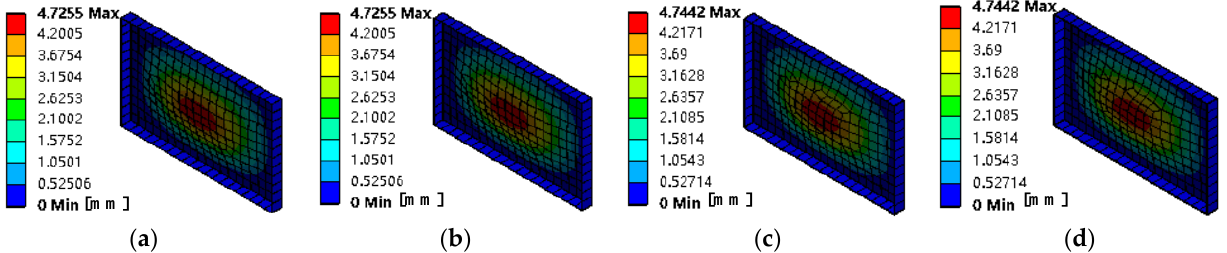
Figure 14. Response diagram of plate with variable edge stiffening thickness. ( a ) 2 mm thickness. ( b ) 3 mm thickness. ( c ) 4 mm thickness. ( d ) 5 mm thickness.